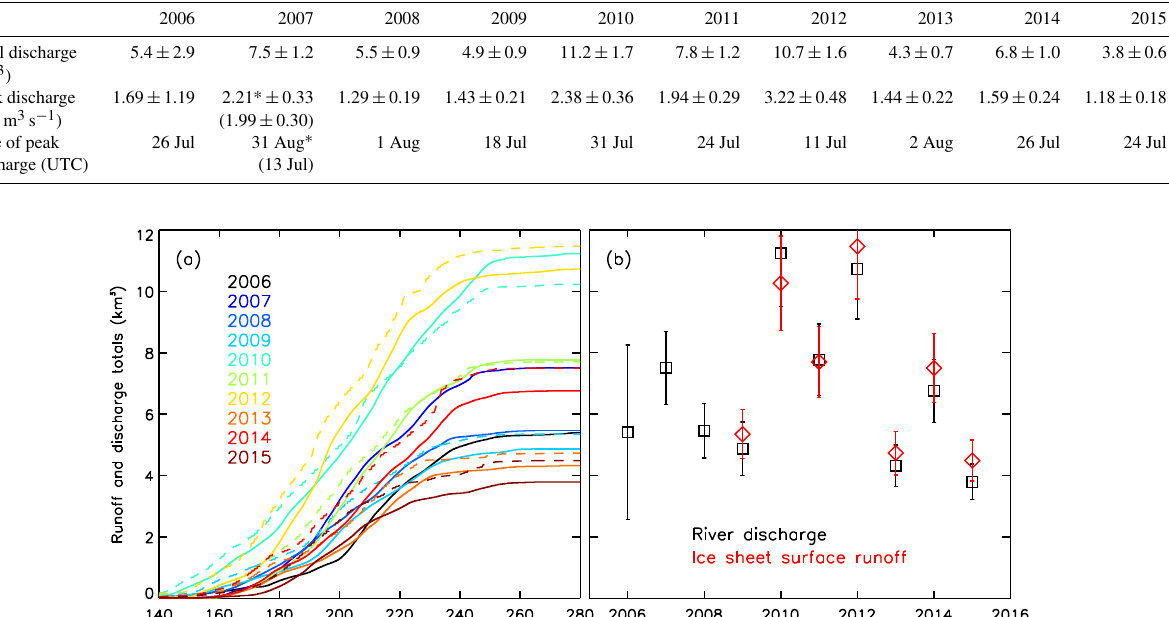
Figure 6. (a) Cumulative Watson River discharge (solid lines) and ice sheet surface meltwater runoff from the Kangerlussuaq catchment (dashes lines). (b) Annual totals and uncertainty of discharge (black) and runoff (red).